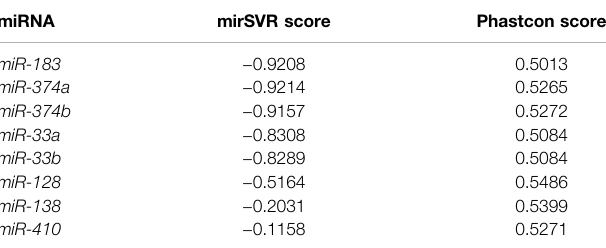
TABLE 3 | mirSVR score and PhastCon